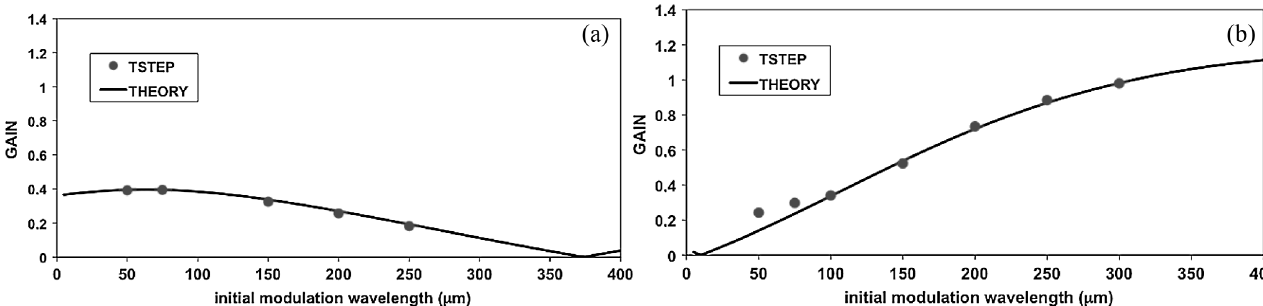
¼ 0 deg , (b) is for a compression 0